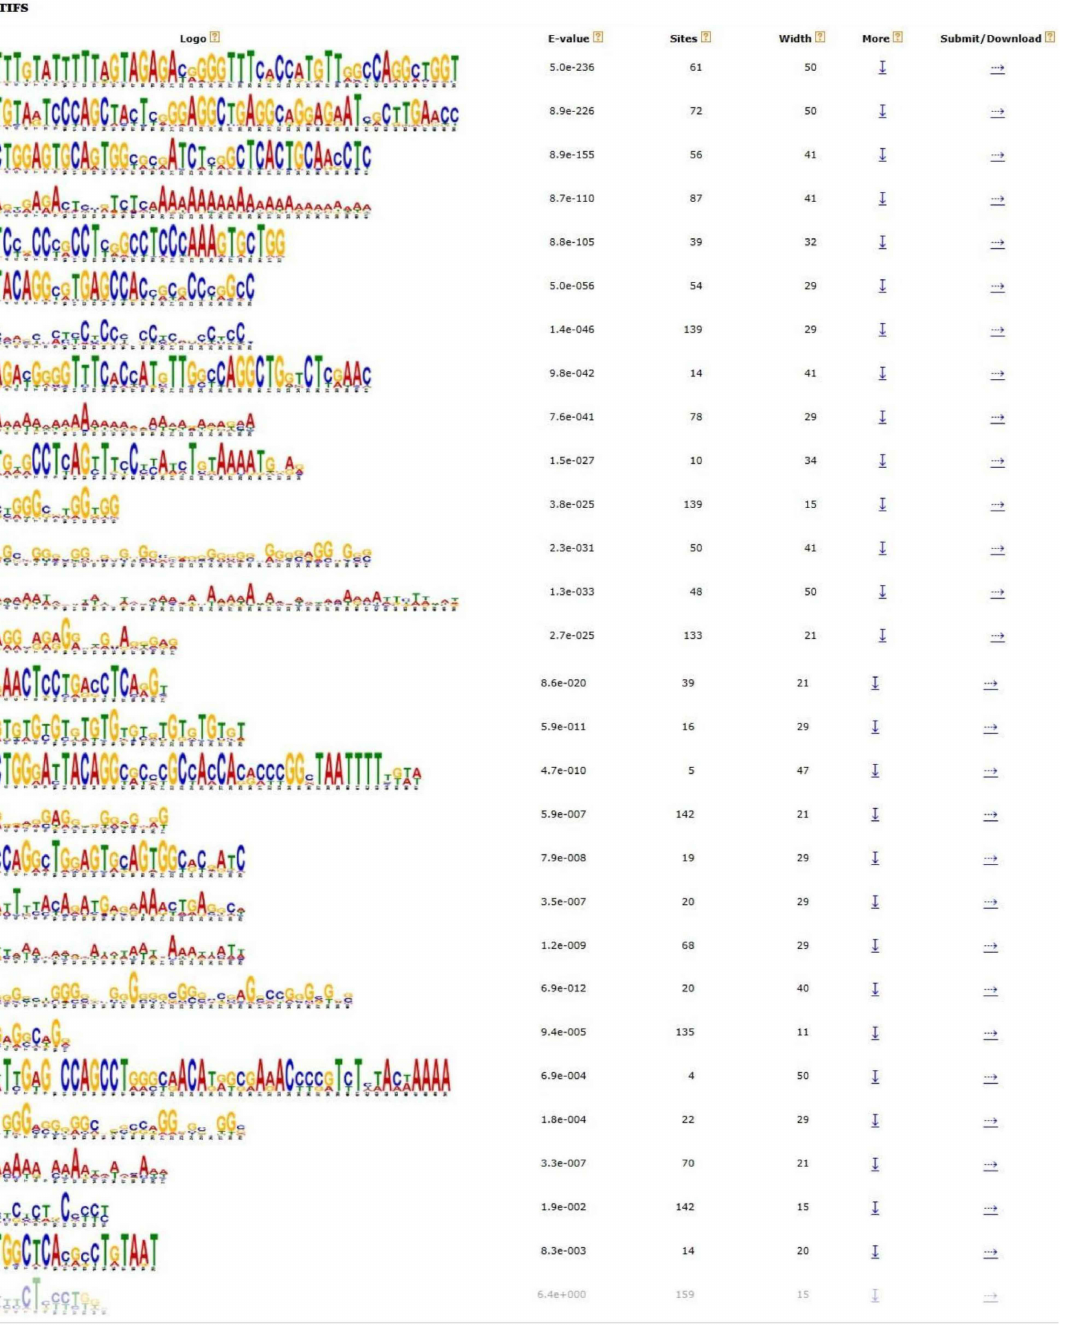
FIGURE 8 | Motif analysis of differentially expressed genes (DEGs). Significant motifs were presented (E value <